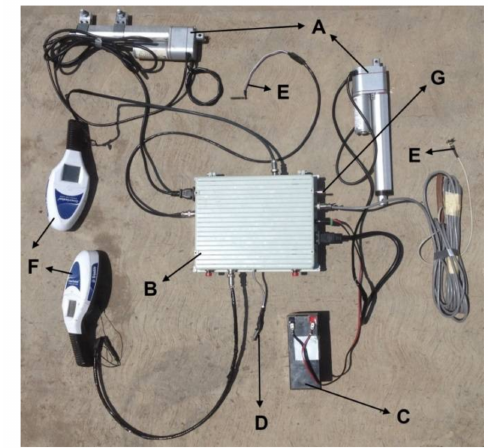
Figure 2. Overview of the external components of the developed VRA-fertilizer kit, including ( A ) electric actuator piston; ( B ) control box; ( C ) 12V Battery; ( D ) Bluetooth transmitter; ( E ) magnetic calibration sensor, ( F ) N-sensor; ( G )